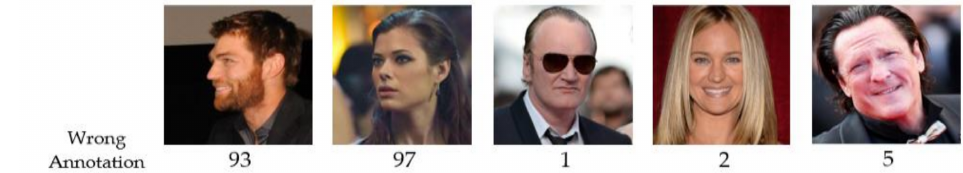
Figure 3. Some of the wrongly annotated image samples in the existing IMDB-WIKI benchmark dataset.